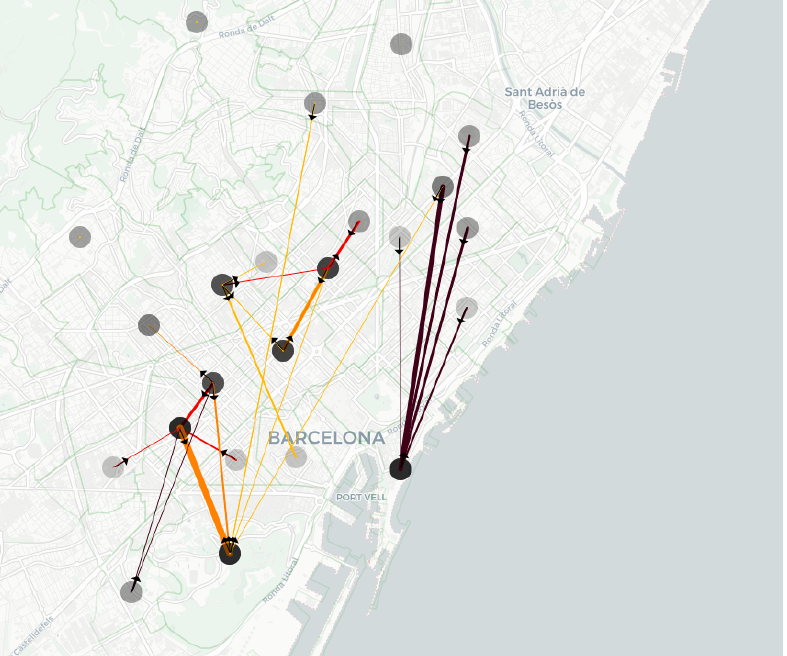
Figure 7. Map of Barcelona showing the most frequent journeys between neighbourhoods, showing those made more than 500 times. The dots represent the neighbourhoods of origin and destination of the trips. The colour of the lines represents the percentage of trips to health centres. The darker the colour is, the more people go to a health centre. The arrows on the lines indicate the direction of the trip. The polygons shown in very light green represent the